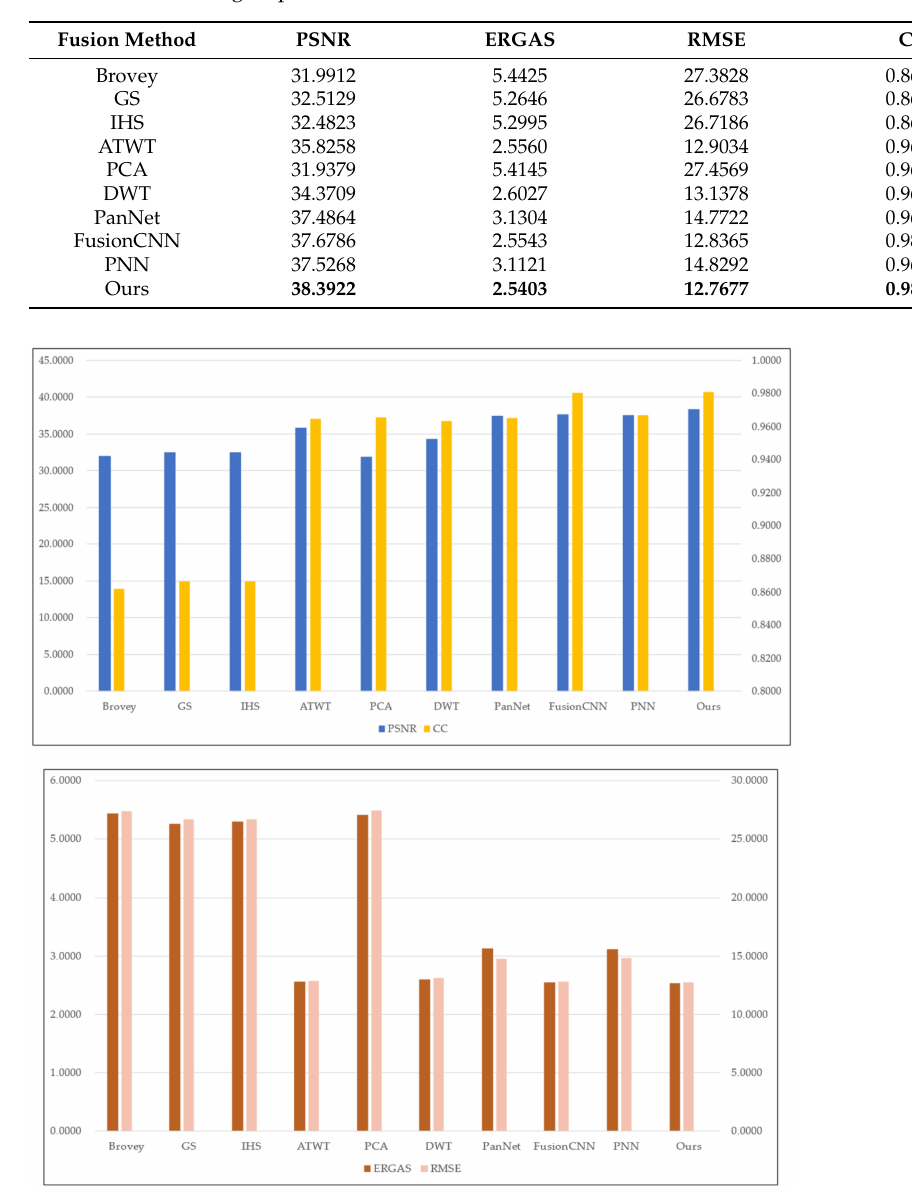
Table 3. The second group evaluation indices of different fusion results.